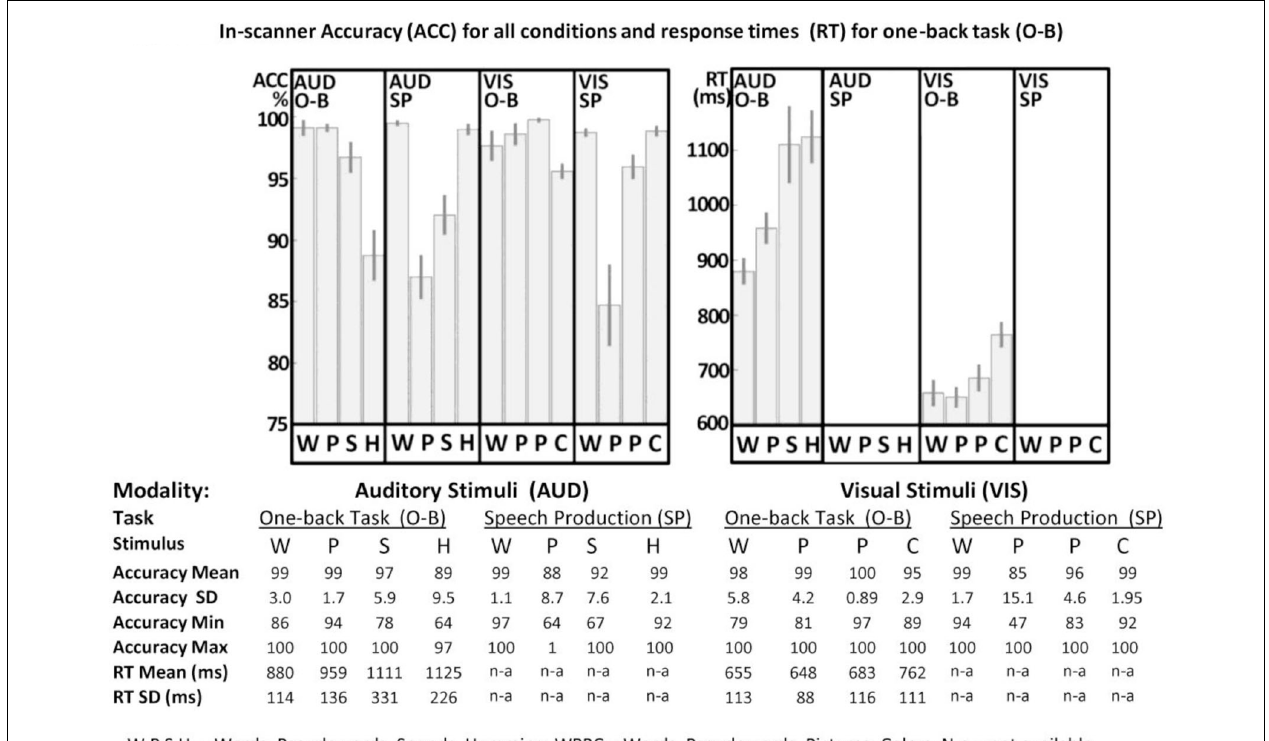
FIGURE 2 | In-scanner performance. Accuracy (ACC) and response times (RT) for one-back (O-B) and speech production (SP) tasks are plotted in the top part of the figure for both visual (VIS) and auditory (AUD) modalities, where error-bars represent standard errors. Full details are provided in the bottom